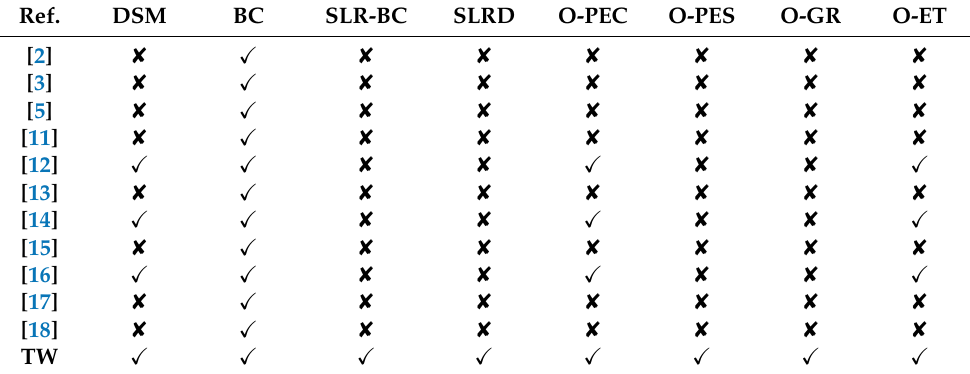
Table 1. Literature Review